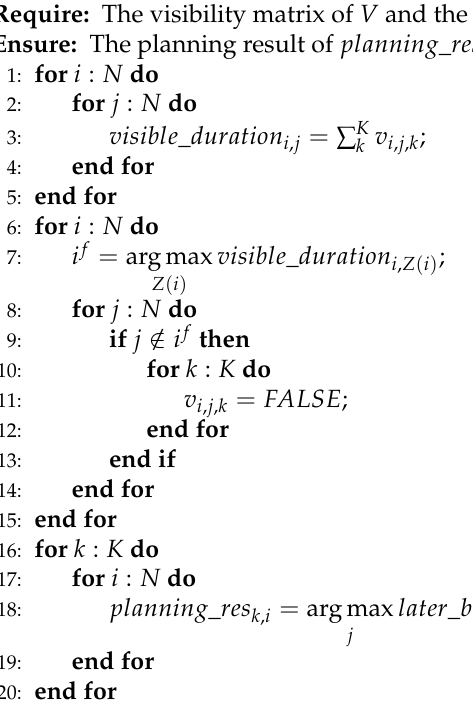
Algorithm 1 Link-building_Planning( V , K